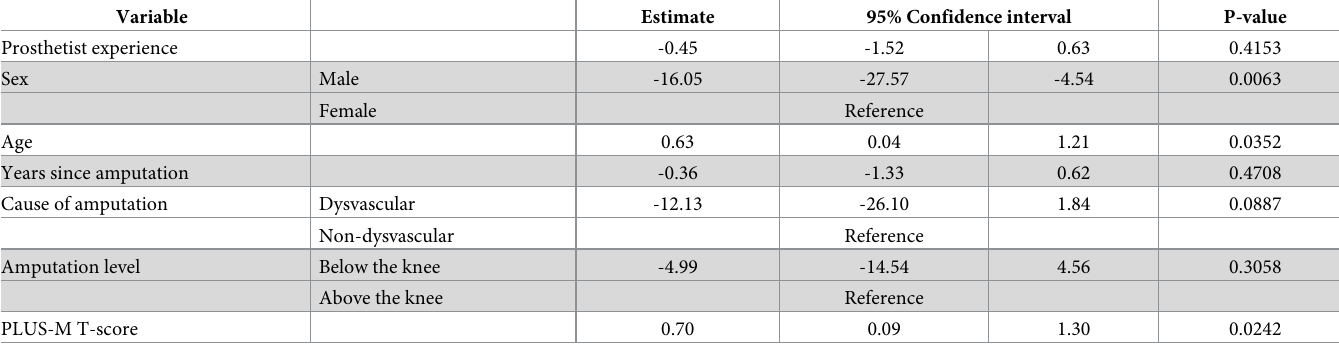
Table 3. Results of the multivariate analysis of the associations between participant characteristics and percentage of internal focus statements received during prosthetic training.